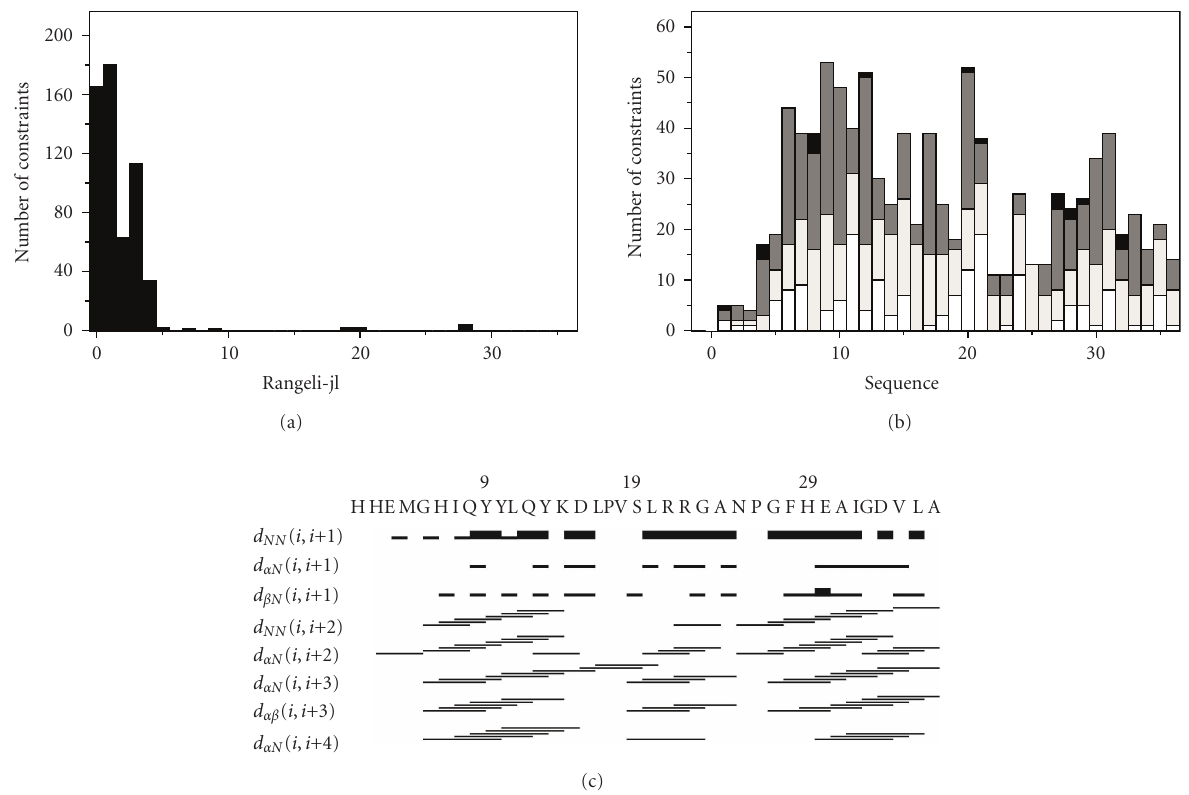
Figure 2: (a) Short-, medium-, and long-range connectivities. (b) Number of NOE constraints per residue (white, gray, dark gray, and black vertical bars represent, resp., intraresidue, sequential, medium-range and long-range connectivities). (c) Schematic representation of the sequential and medium range NOEs involving HN, H α , and H β protons for Zn 2+ -ACE N (37) (corresponds to His 360 -Ala 396 of the human somatic